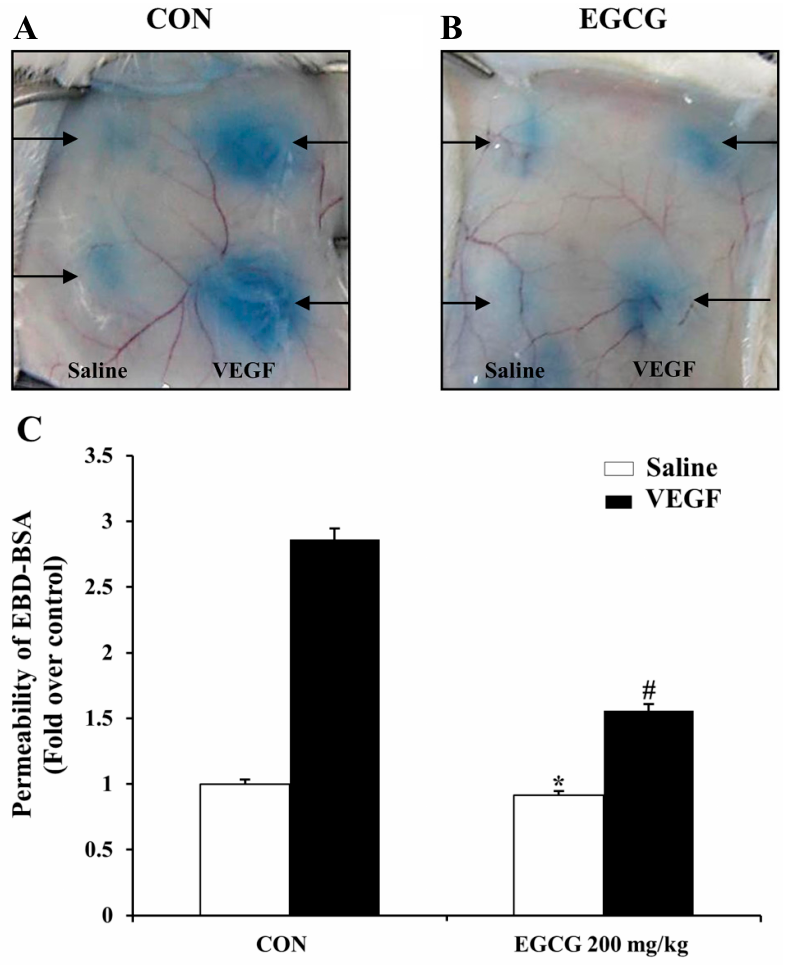
Figure 8. EGCG inhibits VEGF-induced vascular permeability in vivo . ( A ) and ( B ) VEGF induced vascular leakage of serum albumin-bound Evans Blue in the back skin of mice pretreated orally with EGCG (200 mg/kg) or saline for 1.5 h. Figures were selected as representative photograph from three independent experiments. ( C ) Spectrophotometric analysis of vascular leakiness by formamide-extracted Evans Blue dye content. Evans Blue dye content of skin injected with both of VEGF (50 ng) and EGCG (200 mg/kg) was significantly decreased compared with that of skin injected with VEGF (50 ng)